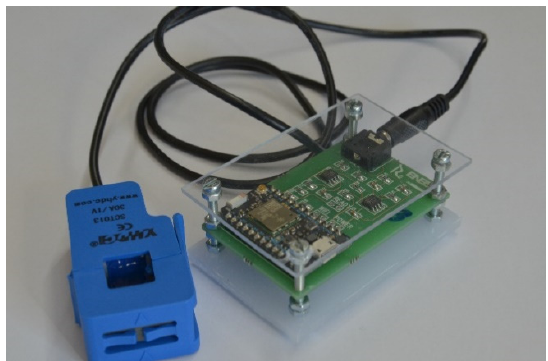
Figure 4. The Photon Particle detailed elements.